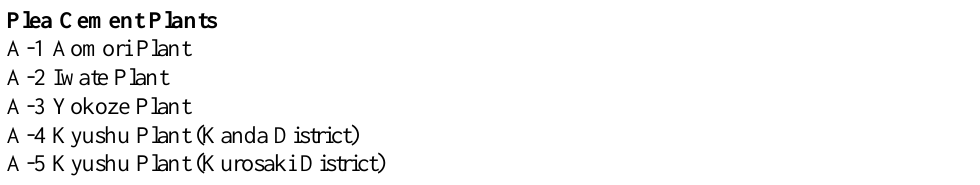
Table 2: Mitsubishi Mineral Resources Group. The Recycling System Plea Cement